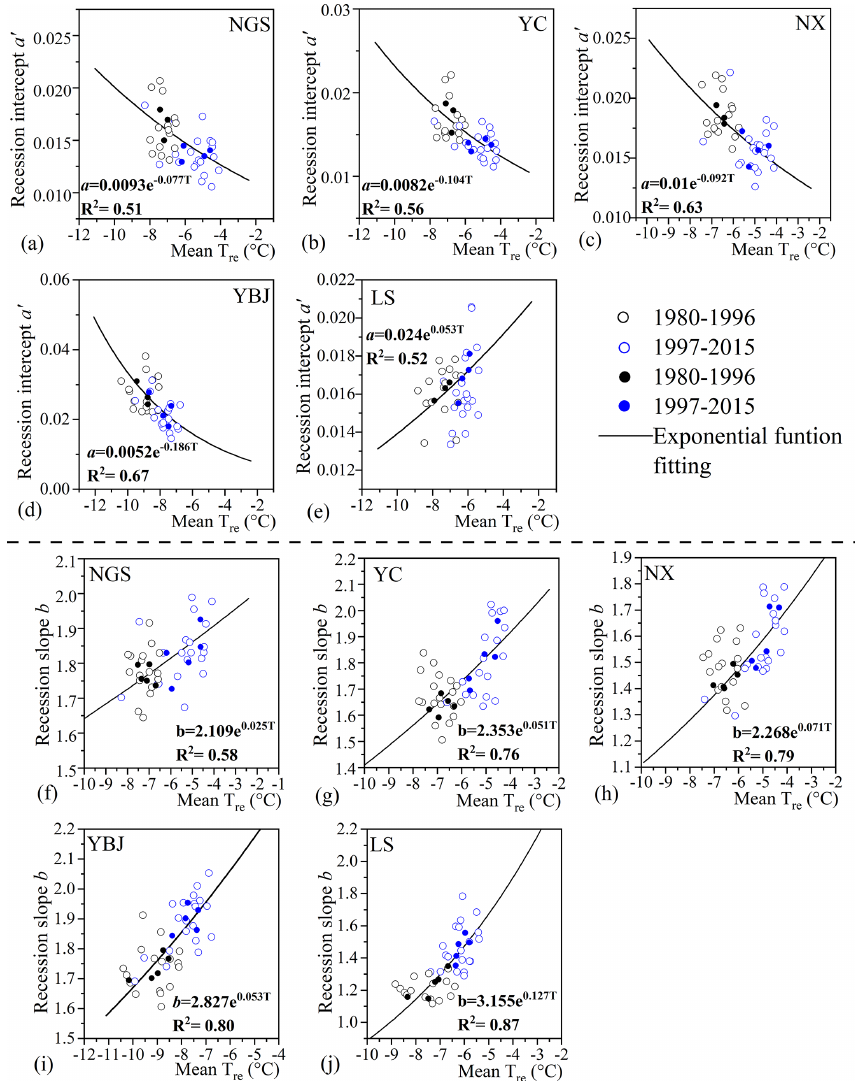
Figure 7. (a–e) The exponential function of a (cid:48) with T re for each subbasin. (f–j) Same as panels (a–e) but for recession slope b . The solid and open circles represent the 4-year average and annual value,